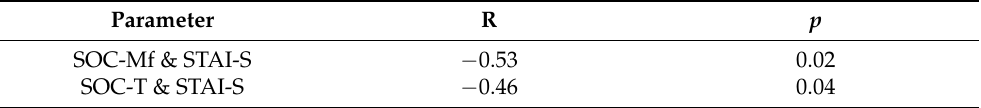
Table 3. Statistically significant correlations between analyzed parameters in urticaria patients manifesting wheals